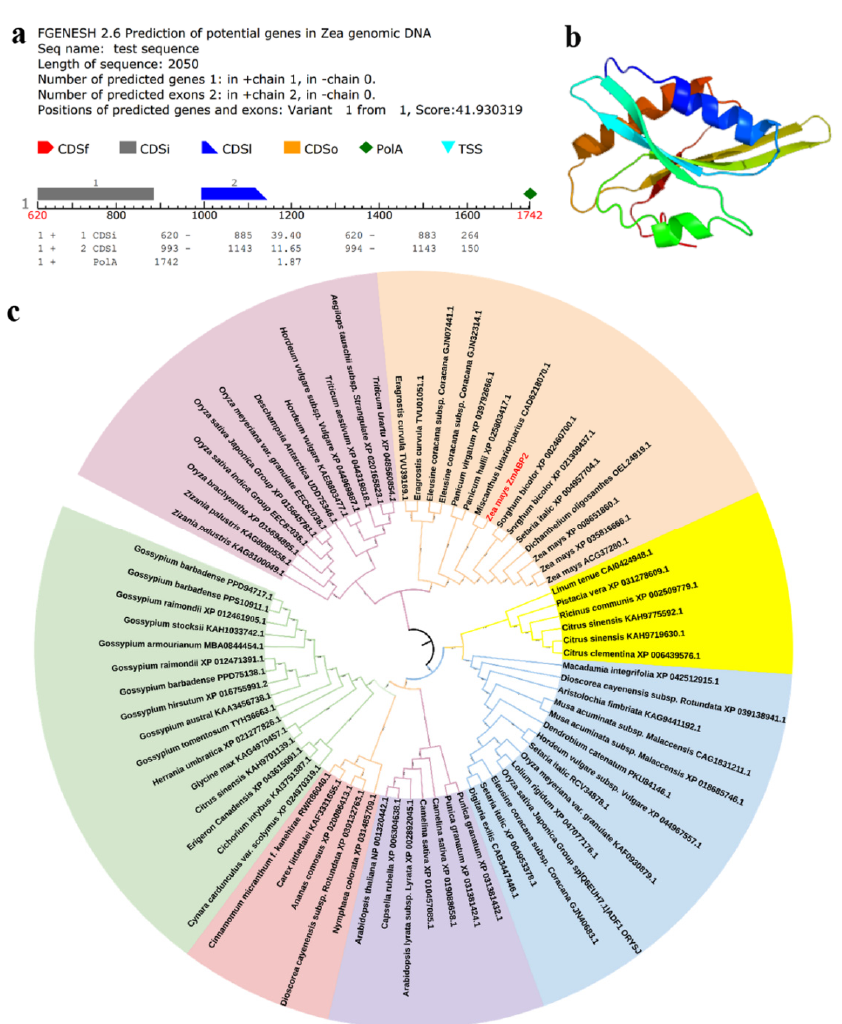
Figure 7. Bioinformatics analysis of the candidate gene ZmABP2 . ( a ) Gene prediction of ZmABP2 gene (TSS: Transcription start site; CDSf: Start exon; CDSI: Terminal exon). ( b ) Tertiary structure of ZmABP2 protein. ( c ) Phylogenetic analysis of ZmABP2 protein.